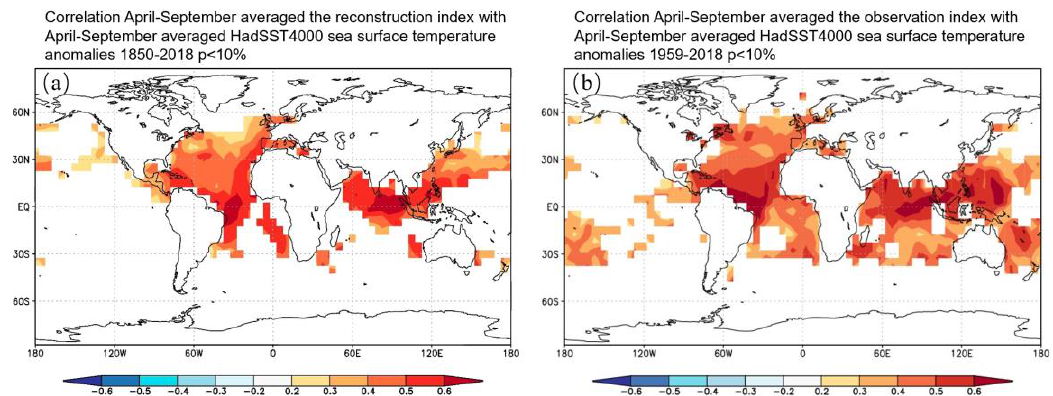
Figure 7. Spatial correlations between ( a ) reconstructed RH AS and April–September HadSST, and ( b ) observed RH AS and HadSST from 1959 to 2018.